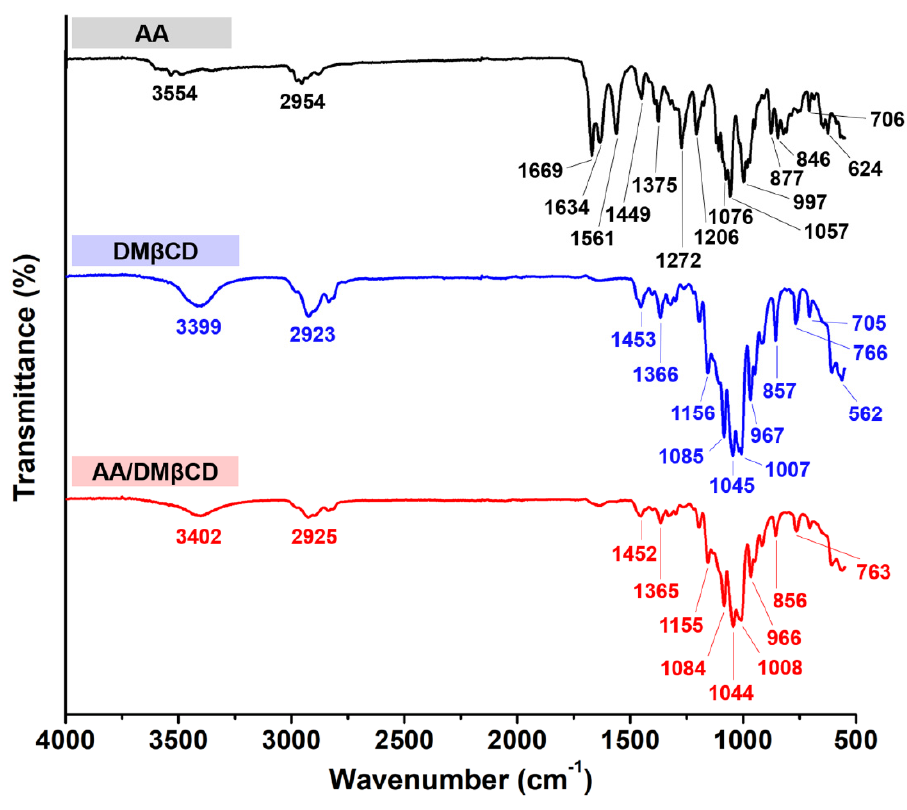
Figure 4. FT-IR spectra of the AA, DM β CD, and AA/DM β CD complex.